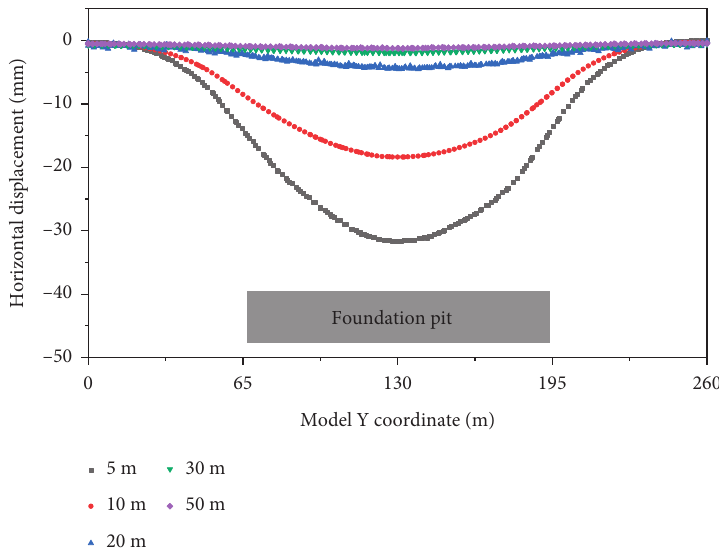
Figure 8: Tunnel horizontal displacement with different distance from the pit. Table 3: Minimum radius of tunnel relative curvature. The distance between right tunnel and foundation pit